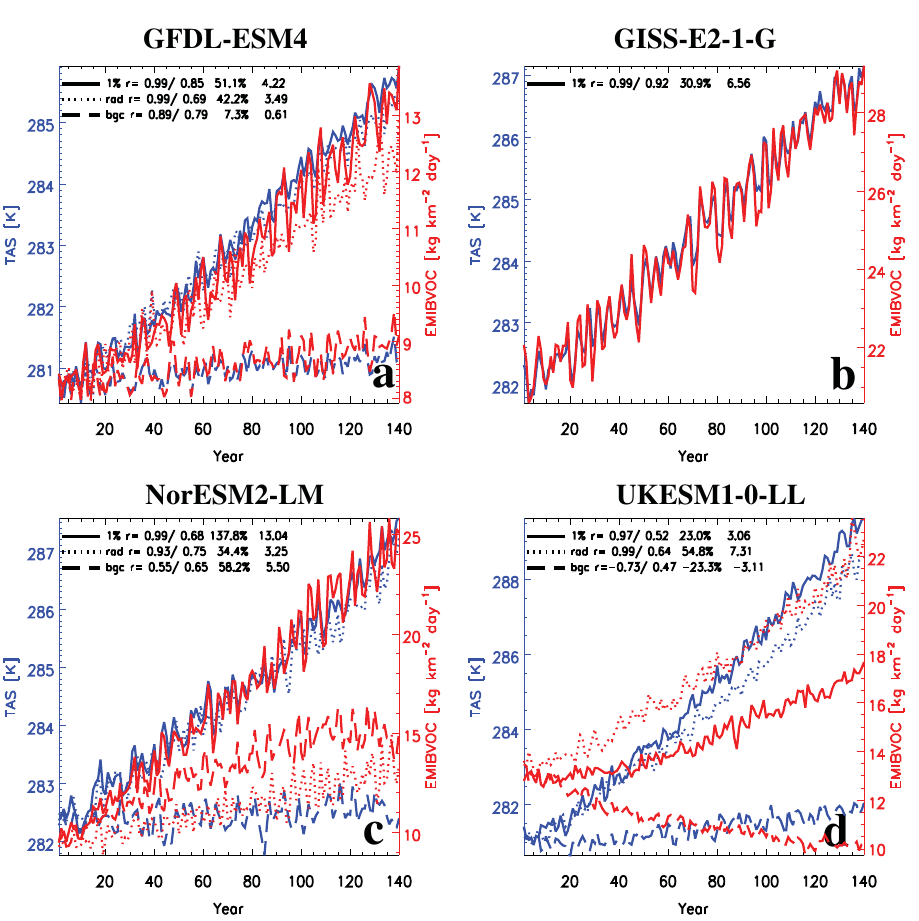
Fig. 5 Global land mean time series of surface temperature and BVOC emissions. Surface temperature (TAS; blue) [K] and BVOC emissions (EMIBVOC; red) [kg km − 2 day − 1 ] for four models that include climate-dependent BVOC emissions, including a GFDL-ESM4; b GISS-E2-1-G; c NorESM2-LM; and d UKESM1-0-LL. Solid, dotted and dashed lines show results from the 1% per year CO 2 , 1% per year CO 2 -rad, and 1% per year CO 2 -bgc experiments (only three models, GFDL-ESM4, NorESM2-LM and UKESM1-0-LL, performed the latter two experiments). Also included is the correlation coef fi cient ( r ), followed by the detrended correlation, the percent change and the absolute change in BVOC emissions (years 100 – 140 relative to 40 years from the preindustrial